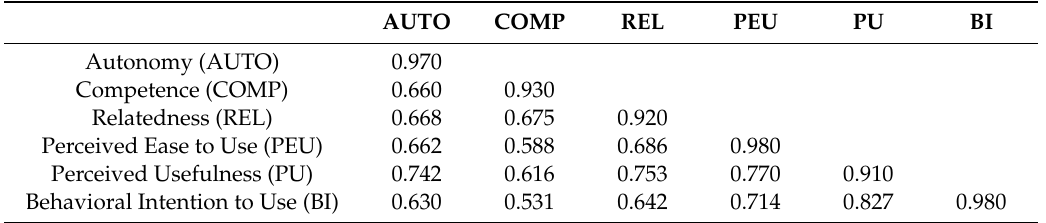
Table 3. Correlation Matrix 1 .